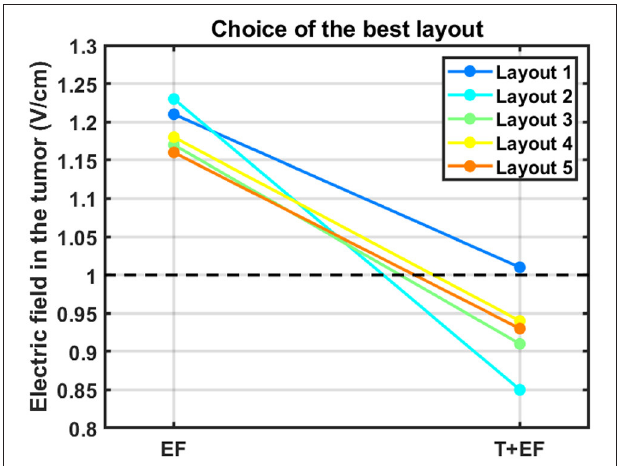
FIGURE 3 | Impact of accounting for the temperature in the choice of the best layout to use. The average electric field intensity in the tumor decreased when this additional parameter was considered (T + EF) compared to when 900mA were injected in both pairs (EF). The black dashed line represents the therapeutic threshold of 1